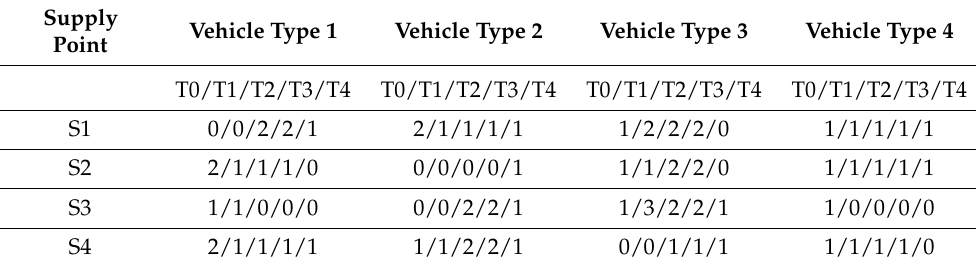
Table 5. Vehicle count of each type at supply points (S1:S4), Time Slot 0. Supply Point